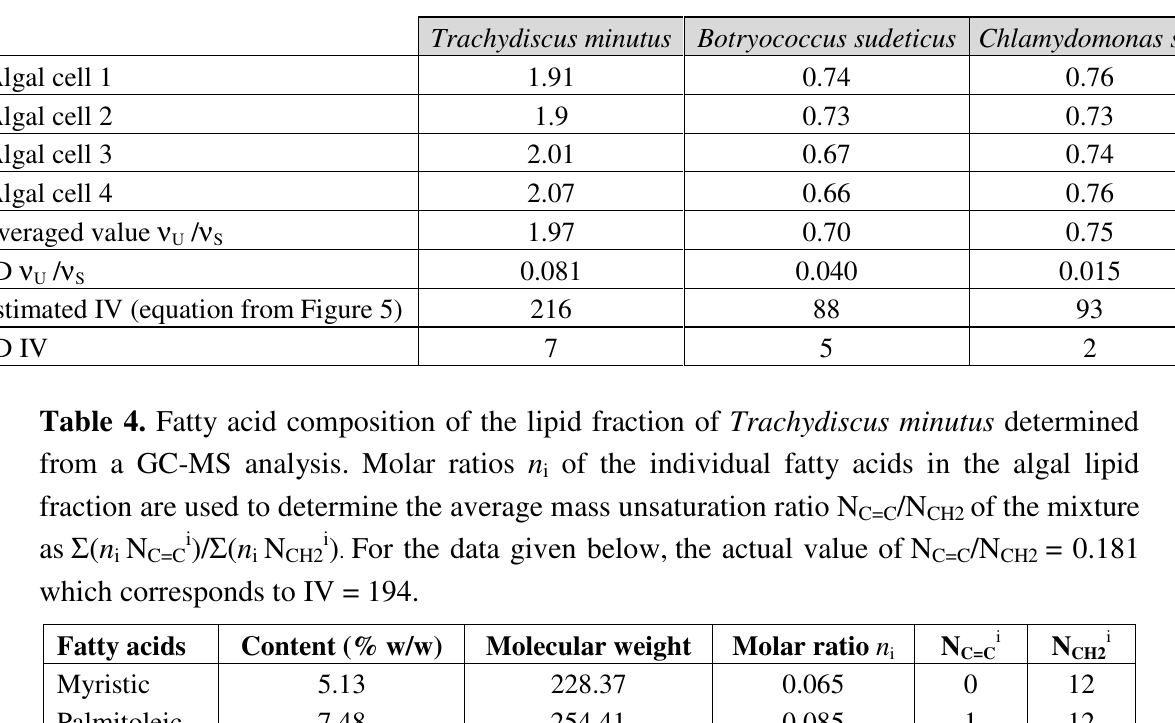
/ ν of the Raman spectral peaks at 1,656 cm −1 and 1,445 cm −1 U S